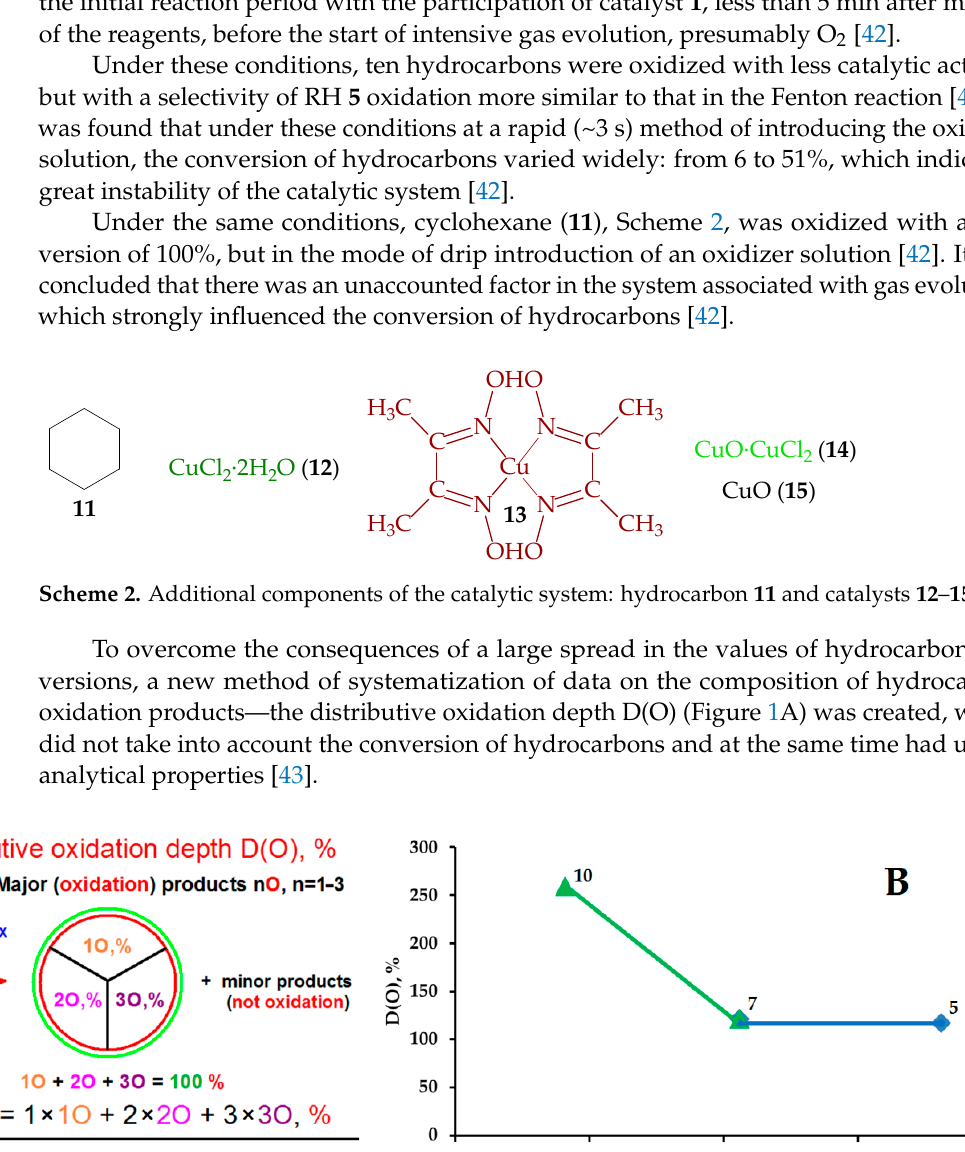
Figure 1. ( A ) The distributive oxidation depth D(O); ( B ) Three characteristic points (RH 5 , 7, and 10 ) on the dependence of D(O) on AIP–the first adiabatic ionization potentials of hydrocarbons RH. Equations of straight lines y = ax + b : blue: D(O) = 117 %; green: D(O) = − 221.55AIP + 2012 [43].